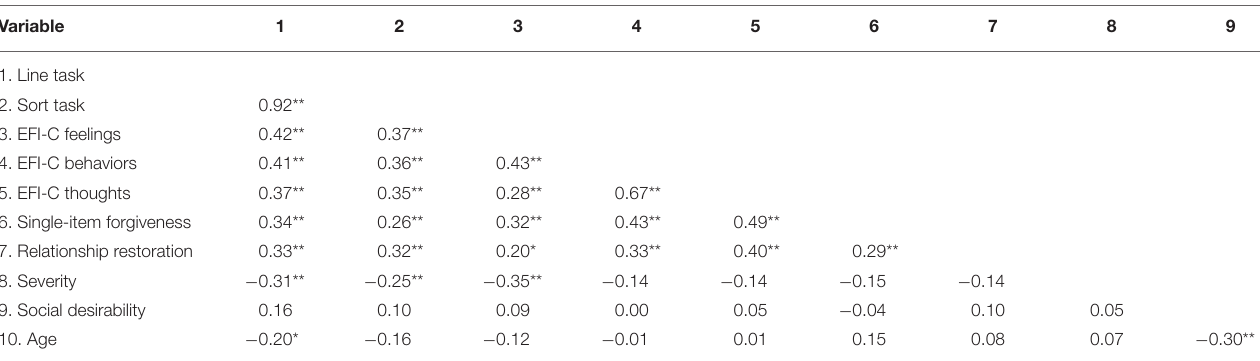
TABLE 3 | Pearson Product Moment Correlation between CFCS Tasks, other forgiveness measures, severity, social desirability, and age (Study 1).